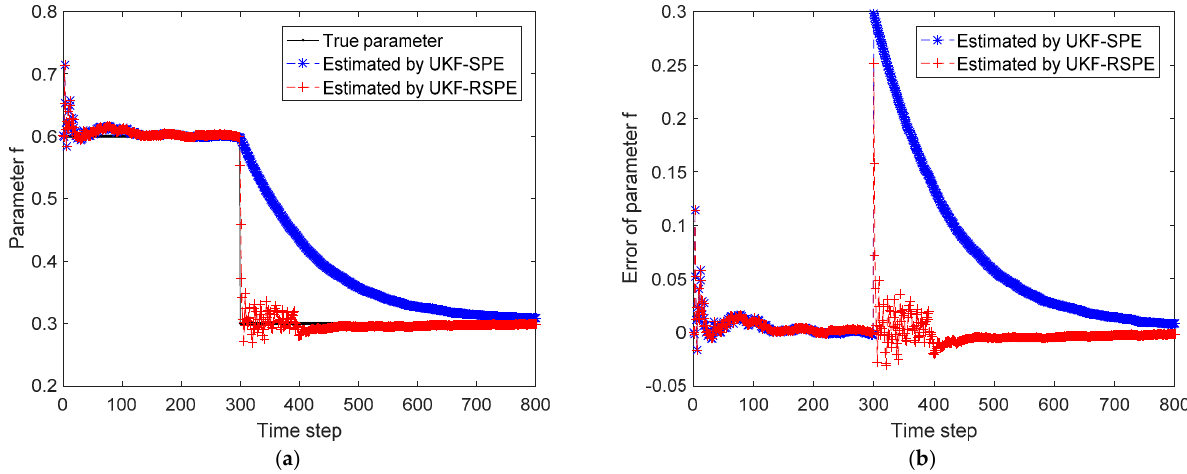
Figure 8. The comparison of the estimated results of the state (cid:101) T k in Case Study 2.1: ( a ) estimated state; ( b ) state error.